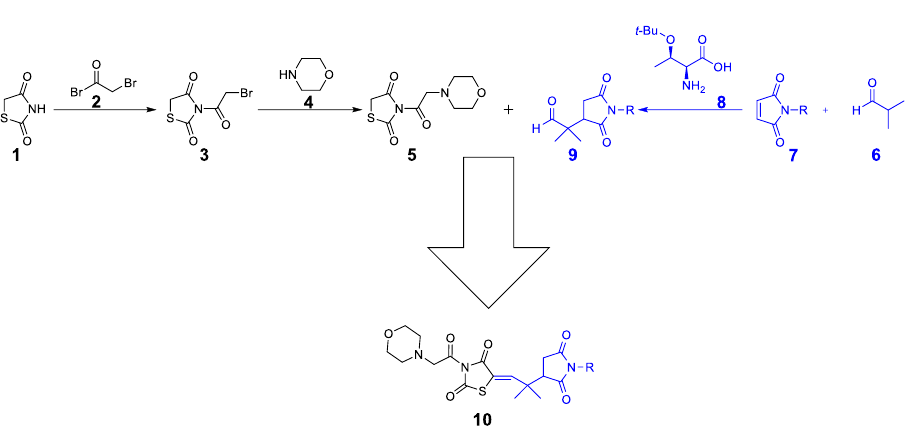
Figure 2. Structures of the synthesized compounds 10a – e . The 1 H NMR (400 MHz in chloroform-D) of compound 10a was 1.17 (s, 3H), 1.21 (s, 3H), 2.47 (dd, J = 16.53, 5.42 Hz, 1H), 2.62 (t, J = 6.98 Hz, 4H), 2.87 (dd, J = 16.49, 8.79 Hz, 1H), 3.09 (dd, J = 5.44, 8.82 Hz, 1H), 3.22 (s, 2H), 3.57 (t, J = 7.11 Hz, 4H), 7.86 (s, 1H), and 8.72 (bs, 1H). Similarly, the 13 C NMR on the same instrument gave chemical shift values of 16.4, 18.2, 29.5, 32.4, 47.6, 53.4, 58.3, 64.5, 117.2, 165.8, 167.6, 172.2, 173.6, 176.1, and 177.8. The analysis calculated for C 17 H 21 N 3 O 6 S C, 51.64; H, 5.35; and N, 10.63 found C, 51.71; H, 5.34; and N, 10.61. The 1 H NMR (400 MHz in chloroform-D) of compound 10b was 1.18 (s, 3H), 1.23 (s, 3H), 2.46 (dd, J = 17.21, 5.86 Hz, 1H), 2.61 (t, J = 7.11 Hz, 4H), 2.91 (dd, J = 17.18, 9.20 Hz, 1H), 2.98 (s, 3H), 3.09 (dd, J = 5.85, 9.20 Hz, 1H), 3.25 (s, 2H), 3.60 (t, J = 7.04 Hz, 4H), and 7.84 (s, 1H). Similarly, the 13 C NMR on the same instrument obtained chemical shift values of 17.3, 19.7, 25.6, 28.4, 30.7, 49.0, 52.9, 57.4, 63.4, 116.7, 165.4, 166.9, 170.7, 174.8, 176.3, and 177.4. The analysis calculated for C 18 H 23 N 3 O 6 S C, 52.80; H, 5.66; and N, 10.26 found C, 52.87; H, 5.67; and N, 10.23. The 1 H NMR (400 MHz in chloroform-D) of compound 10c was 1.17 (s, 3H), 1.24 (s, 3H), 2.49 (dd, J = 17.30, 5.90 Hz, 1H), 2.59 (t, J = 7.14 Hz, 4H), 2.93 (dd, J = 17.28, 9.14 Hz, 1H), 3.06 (dd, J = 5.89, 9.12 Hz, 1H), 3.24 (s, 2H), 3.61 (t, J = 7.14 Hz, 4H), 7.26 – 7.31 (m, 2H), 7.35 – 7.41 (m, 1H), 7.42 – 7.48 (m, 2H), and 7.85 (s, 1H). Similarly, the 13 C NMR on the same instrument presented chemical shift values of 17.6, 20.1, 25.6, 28.0, 29.3, 49.4, 54.1, 56.7,